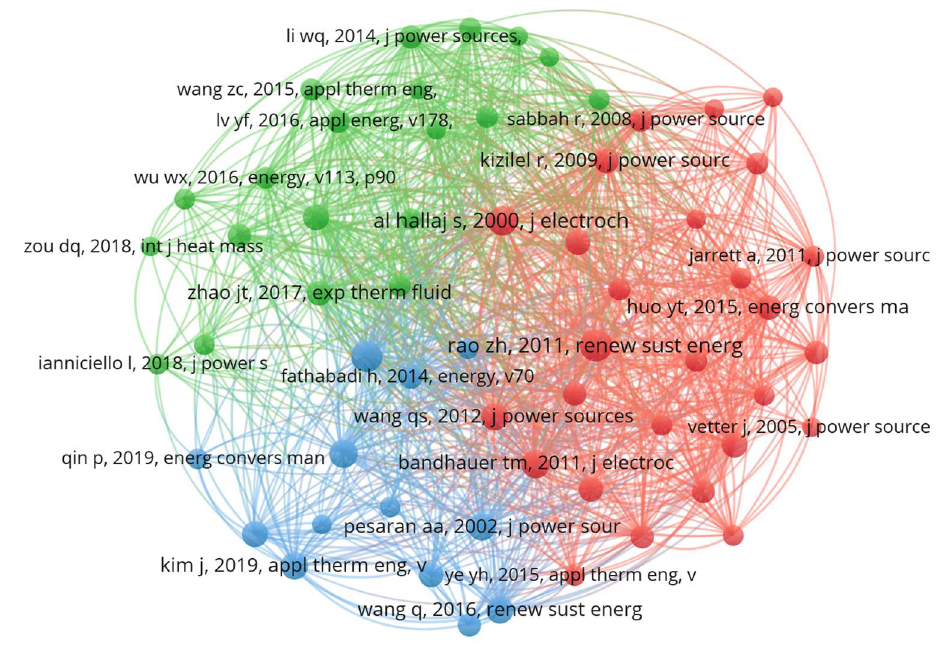
Figure 7. Reference co-citation network of reviews.